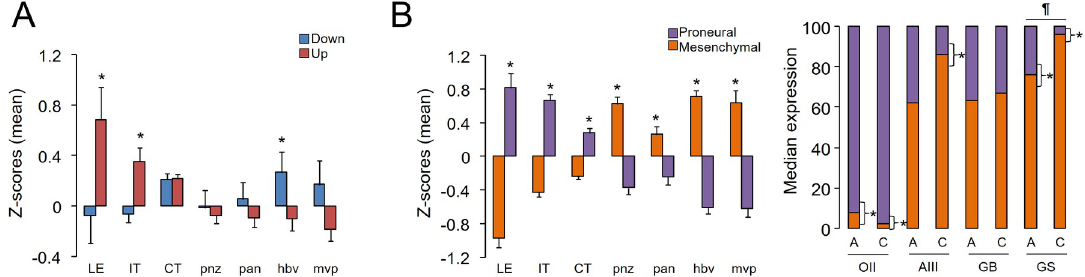
Fig 4. Tumour aspirates and core resections show slight regional differences. A , Mean ± s.e.m. of the Z-scores obtained for the DEGs across the tumoural regions defined in the Ivy GAP website: LE, leading edge; IT, infiltrating tumour; CT, cellular tumour; pnz, perinecrotic zone; pan, pseudopalisading cells around necrosis; hbv, hyperplastic blood vessels; mvp, microvascular proliferation (see ref. [21] for further explanations). � , P < 0.05, Mann-Whitney’s test between the mean values of down- and upregulated genes within each compartment. B , On the left, the same analysis was performed with the proneural and mesenchymal markers defined in Materials and Methods; on the right, the median normalized expression values of these markers in our FFPE samples. � , P < 0.05, Mann- Whitney’s test between the overall expression values of proneural and mesenchymal genes within each sample. { , P < 0.05, Mann- Whitney’s test between the overall expression values of mesenchymal genes between the aspirate and the